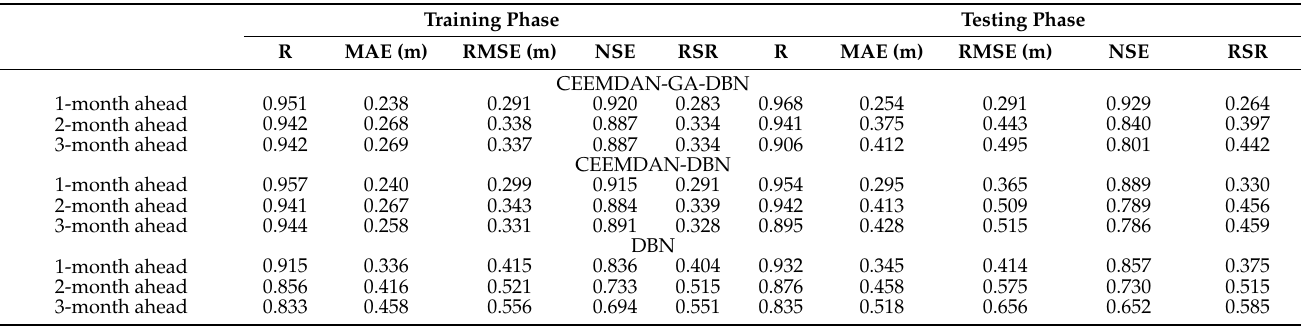
Table 4. Performance metrics of the hybridized CEEMDAN-GA-DBN, CEEMDAN-DBN and DBN models in the training and testing phases for 1-, 2- and 3-month ahead GWL forecasting of Well II.